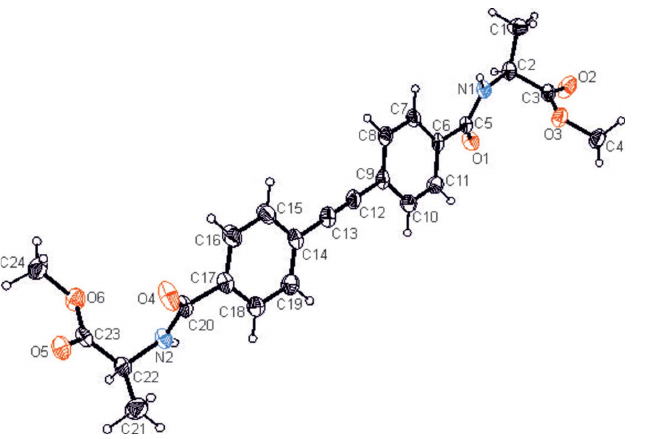
Figure 3 Packing diagram of the title compound. The intermolecular contacts are shown as dashed lines.